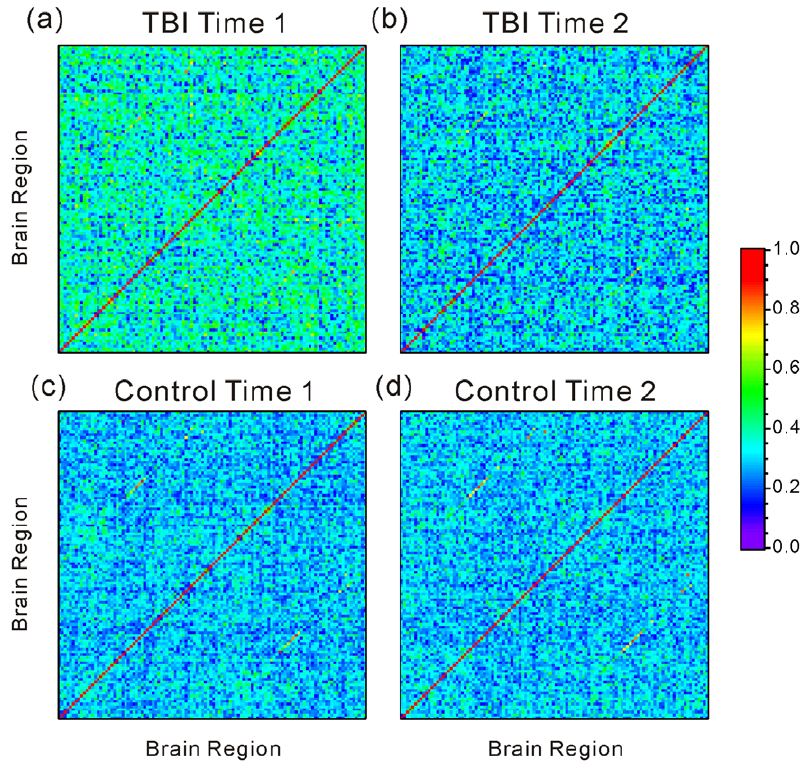
Figure 1. Mean absolute partial correlation matrix of TBI. The averaged absolute partial correlation matrix of TBI at (a) Time 1 and (b) Time 2, and Healthy subjects at (c) Time 1 and (d) Time 2. Both matrices consist of correlation coefficients of all pairs of 112 regions. The list of brain regions we used in this analysis are shown in Table S1. Each component in the matrix indicates the mean absolute strength of the functional connectivity between a pair of brain regions. The correlation coefficients are color coded.